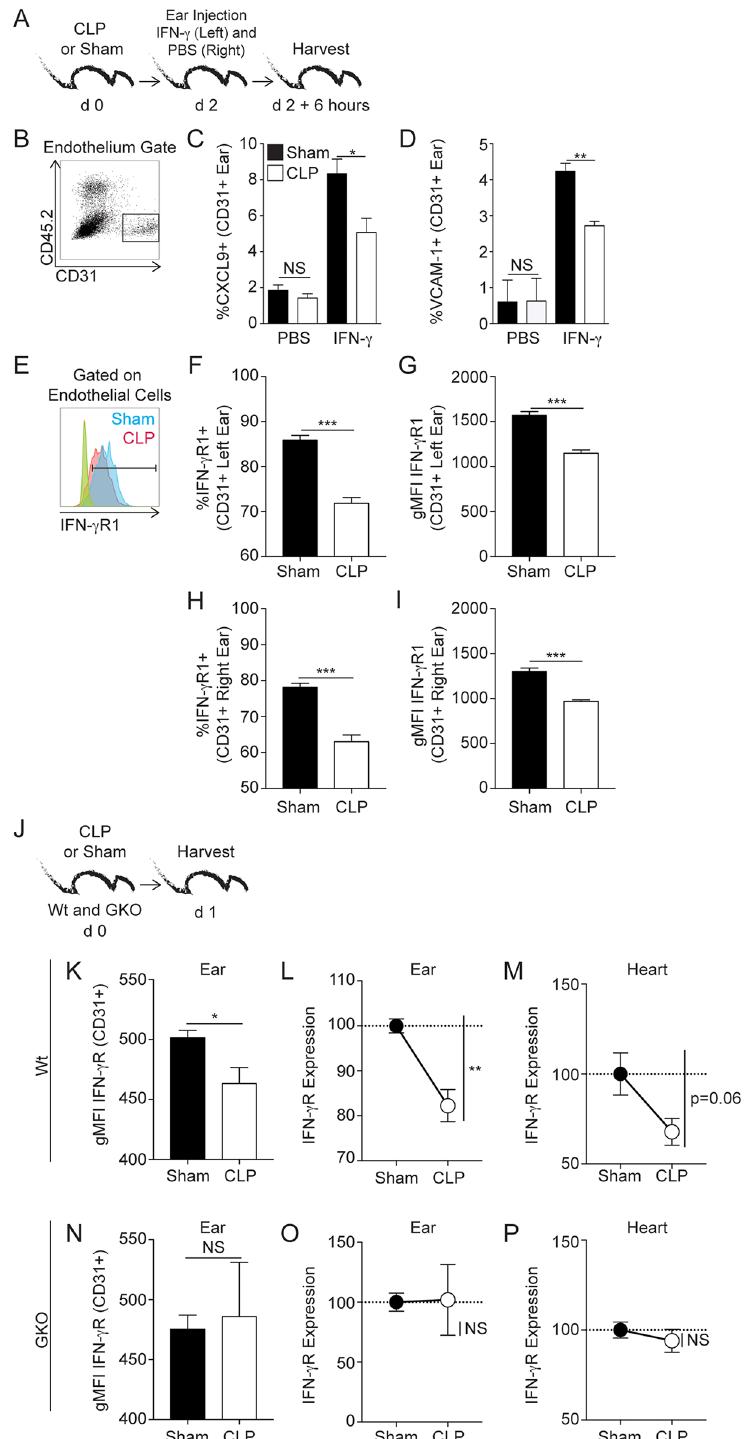
Fig 6. Sepsis impairs the capacity of endothelial cells to expressmolecules that promote IFN- γ mediated bystander recruitment. (A) Experimental Design. Naive C57Bl/6mice underwentCLP or sham surgery. After 2 days, the mice received intradermal injectionsof 5 μ g recombinant IFN- γ (total volume 50 μ L) in the left ear and 50 μ Lof PBS in the right ear. Ears were harvested6 hours later and vascular endothelial cells analyzed.(B) Representative gating of skin endothelialcells (CD31+CD45.2-). (C) Frequency of